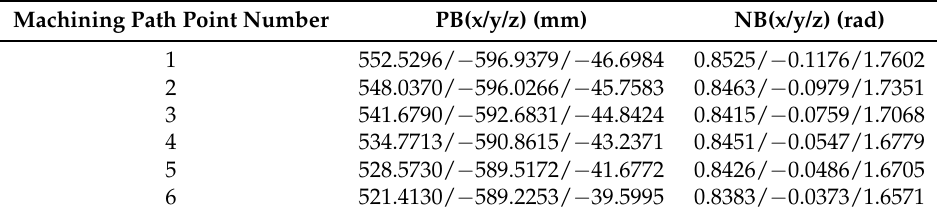
Table 4. Machining path points in the robot base frame after frame